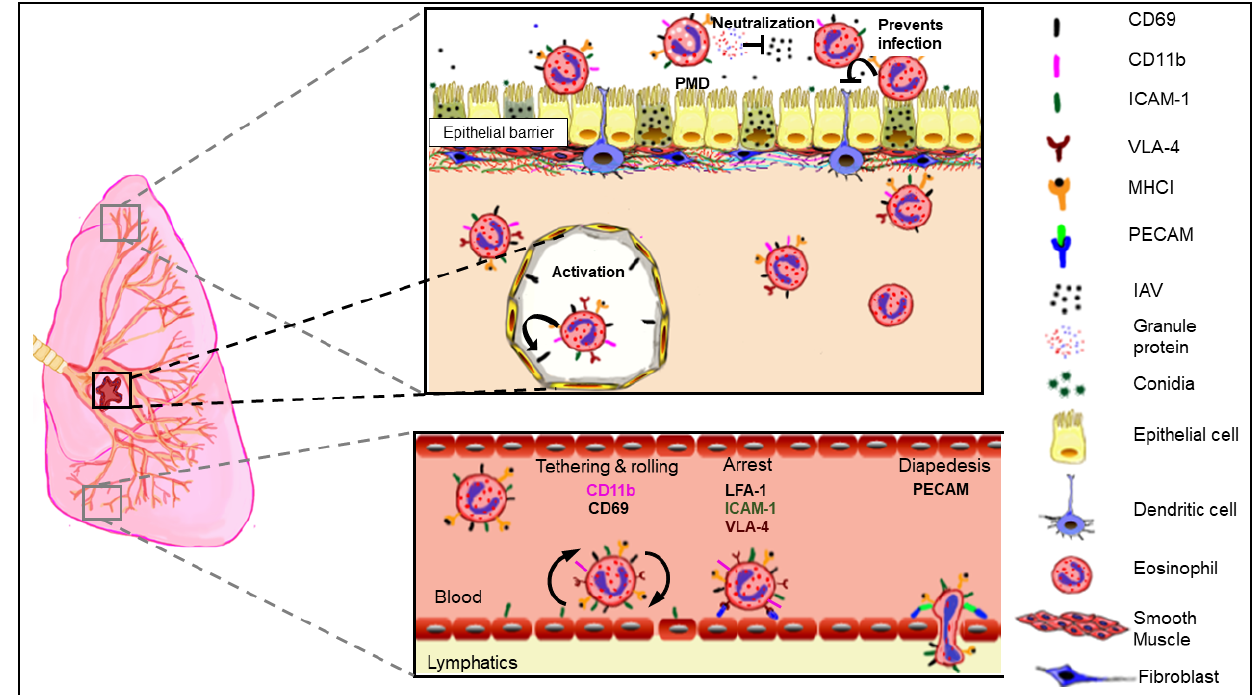
Figure 7. Schematic representation of conceptual model of eosinophil responses during influenza A virus (IAV) infection. Eosinophils may neutralize IAV directly or indirectly at the apical surface of the epithelial barrier. Infected eosinophils may engage in crosstalk with pneumocytes, thereby enhancing antiviral host protective mechanisms in these cells. Eosinophils activated by IAV may migrate to the lymphoid organs by upregulating surface expression of adhesion markers to interact with T cells.